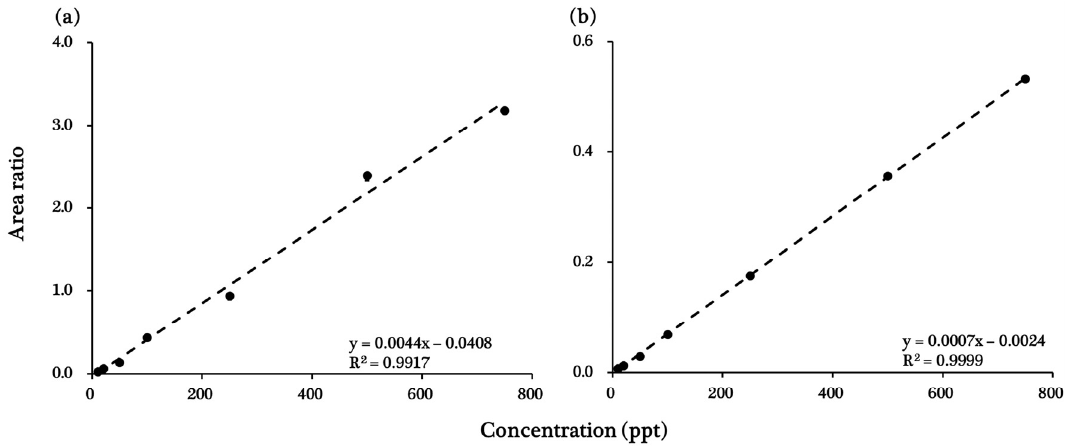
Figure 1. Calibration curves for ( a ) tiamulin and ( b ) clanobutin. These calibration curves are representative of the 41 target pesticides and veterinary pharmaceuticals; calibration curves for the remaining 39 target chemicals are available in the Supplementary Materials (Figure S3).